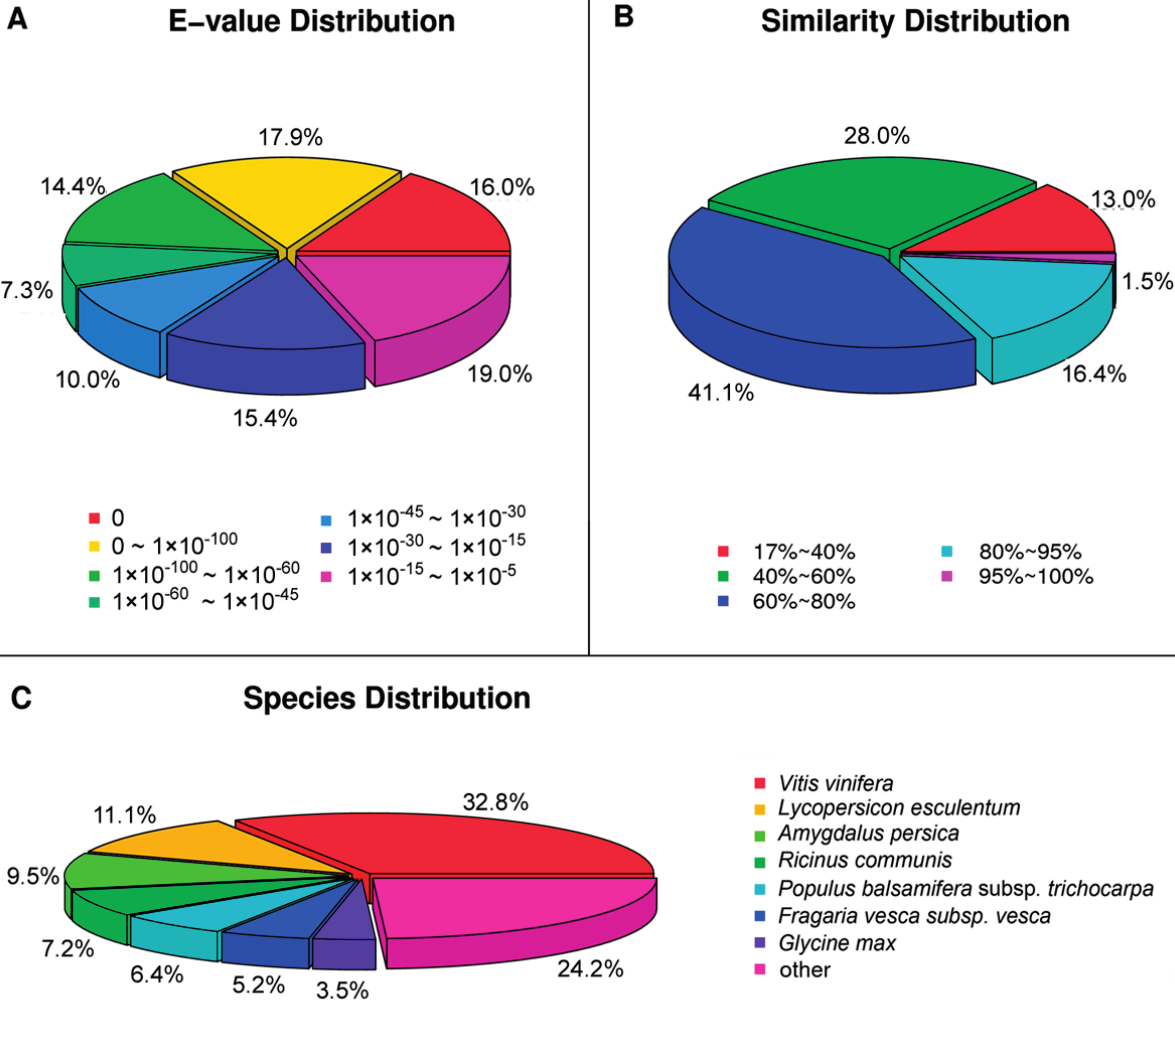
Figure 4. Characteristics of homology search of query sequences aligned by BLASTx to the NCBI nonredundant (NR) database. ( A ) E -value distribution of BLAST hits for matched unigene sequences, using an E -value cutoff of 1.0 × 10 − 5 ; ( B ) Similarity distribution of top BLAST hits for each unigene; ( C ) Species distribution of the top BLAST